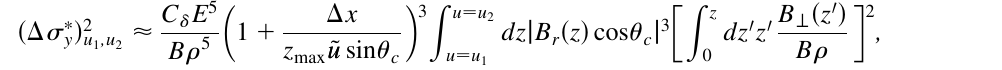
Fig. 5(c), u Assume that for u